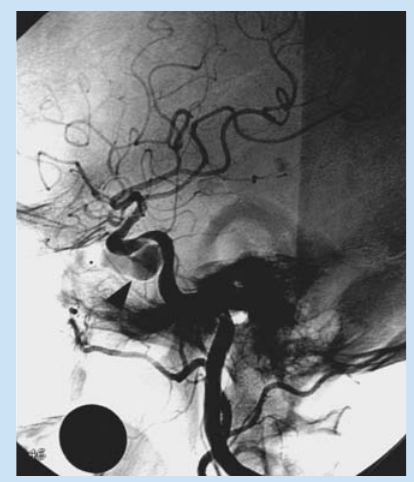
Fig. 2b. Lateral common carotid angiogram follow- ing embolisation with one balloon (arrow) and preservation of the carotid artery.